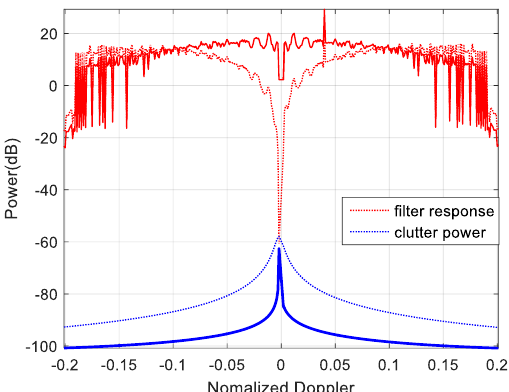
Figure 13. Comparison between the proposed method and traditional processing aiming at a −20 dBsm object, where the solid lines indicate poor clutter suppression under −60 dBm noise.